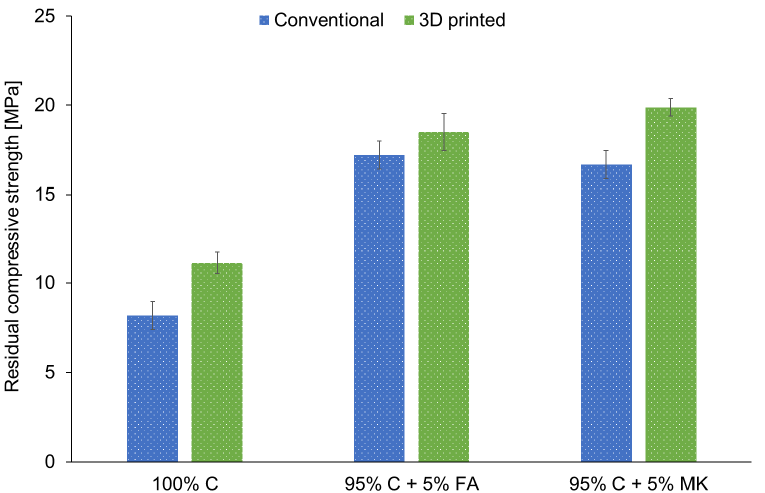
Figure 5. The residual compressive strength after the fire resistance tests for concrete (100% C) and concrete-geopolymer hybrids based on fly ash (95% C + 5% FA) and metakaolin (95% C + 5% MK) that were cast and 3D printed.